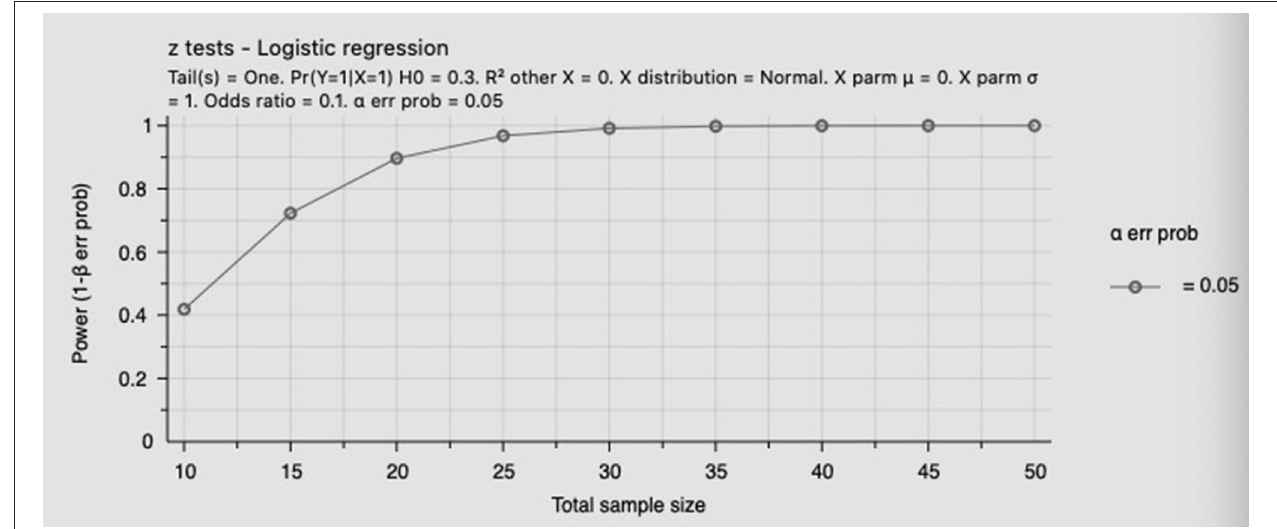
FIGURE 3 | Power analysis for high HbA1c group.